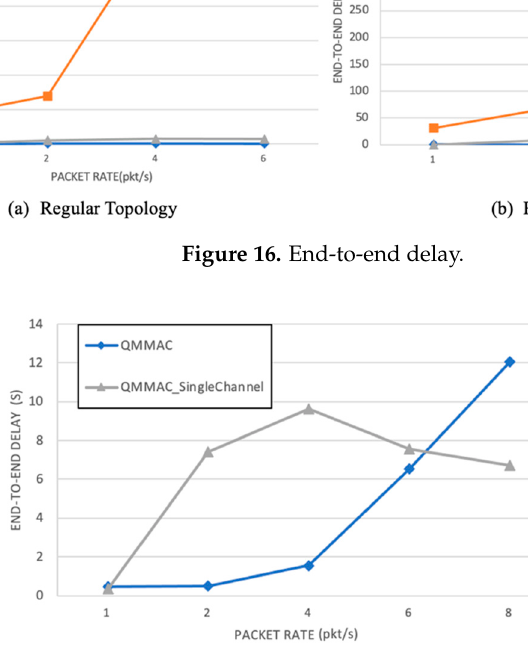
Figure 17. End-to-end delay for QMMAC and QMMAC-single channel.